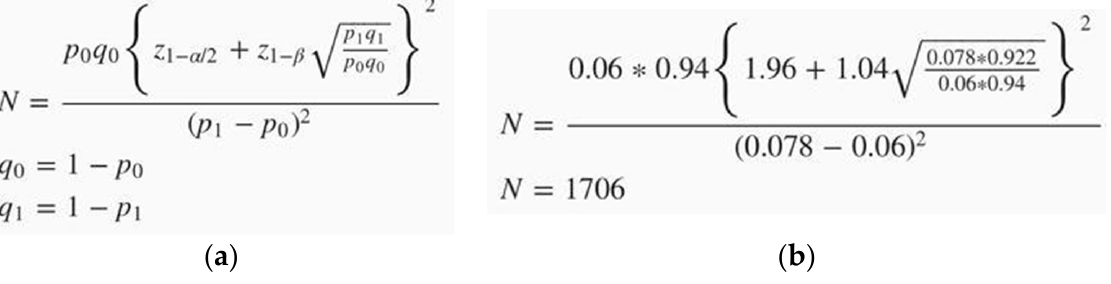
Figure 2. Sample size count: ( a ) ‘classic’ formula for counting; ( b ) formula and counting process for present